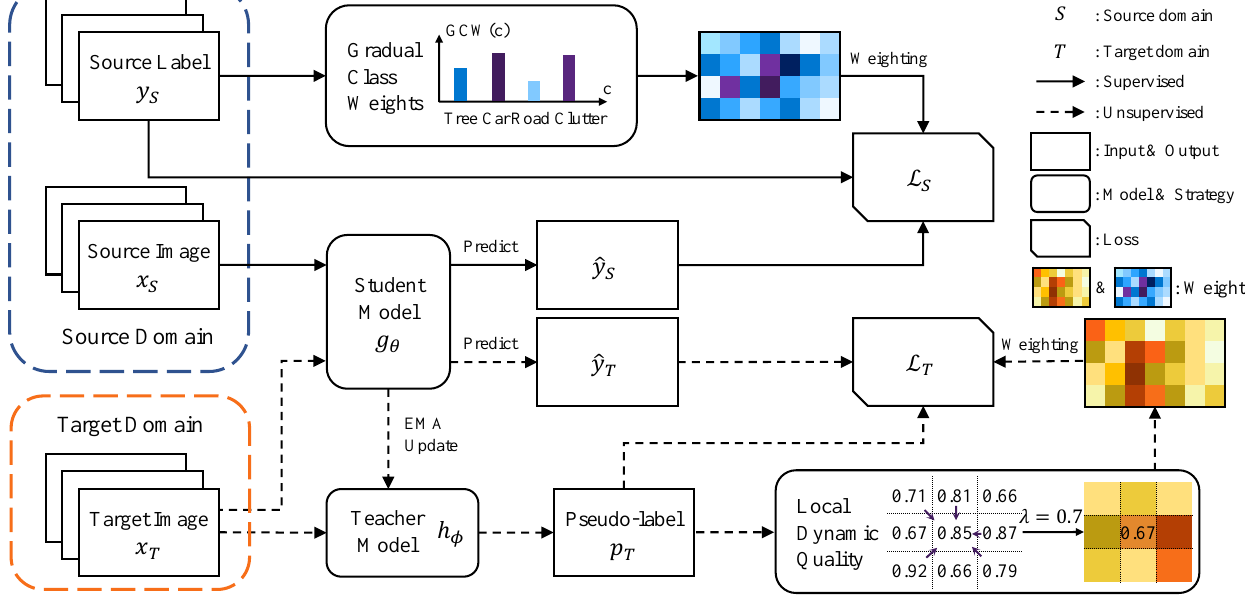
Figure 1. Overview of our self-training framework with Gradual Class Weights and Local Dynamic Quality. Source images x S and source labels y S are trained together in a supervised way with GCW. Pseudo-labels p T are generated by teacher model h φ in place of the target labels y T . Target images x T and pseudo-labels p T are trained together with LDQ. The darker the color is in GCW and LDQ, the larger the weight of the corresponding class and pseudo-label